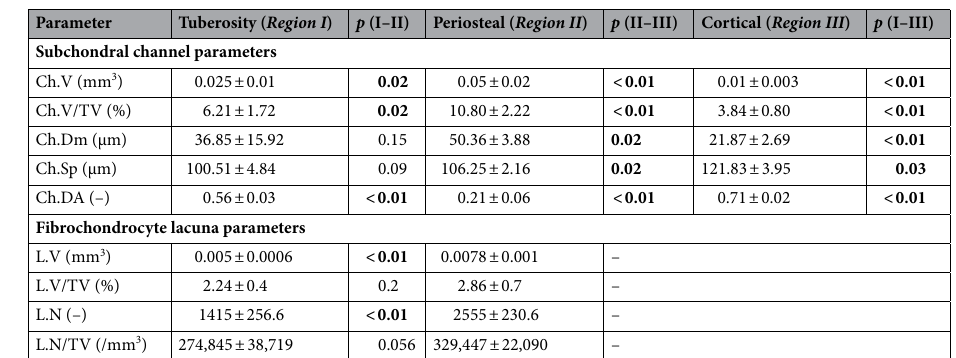
Table 1. Global morphometric parameters used to characterize bone microporosity. Values are mean ± standard deviation. Statistically significant p values (p < 0.05) are shown in bold. Ch.V total channel volume, Ch.V/TV channel volume density, Ch.Dm mean channel diameter, Ch.Sp mean channel separation, Ch.DA channel degree of anisotropy, L.V total lacuna volume, L.V/TV lacuna volume density, L.N lacuna number, L.N/TV lacuna number density.